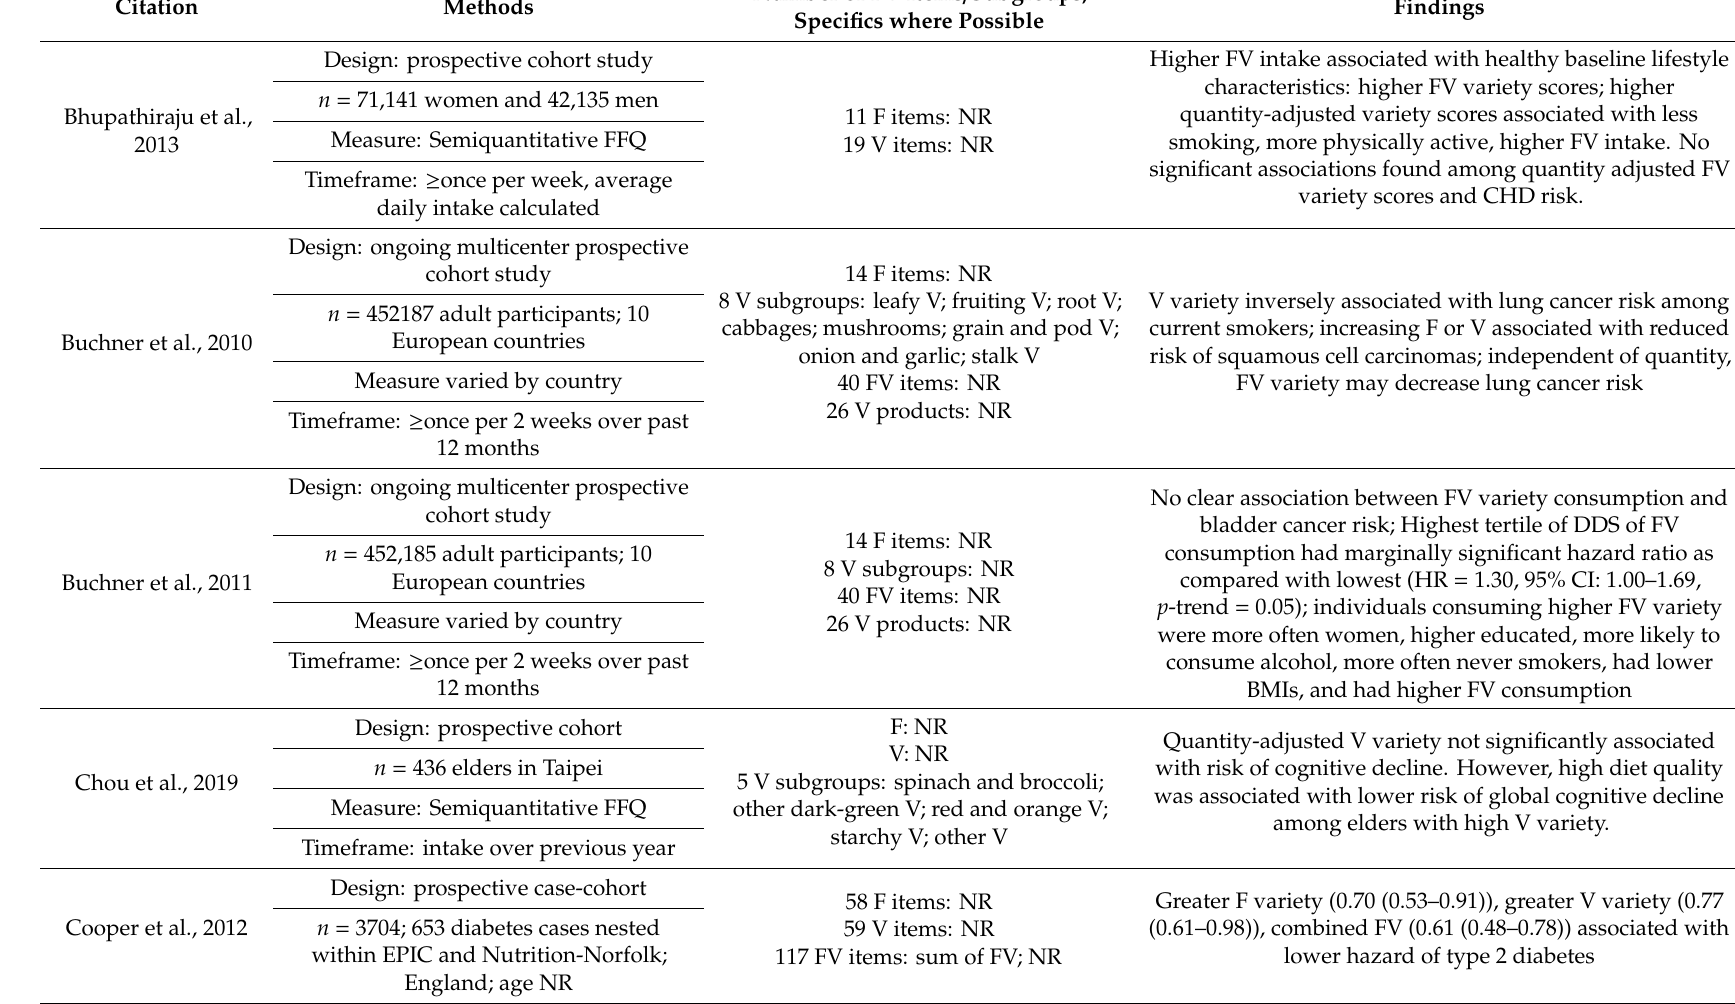
Table 4. Cohort studies, from the literature, assessing fruit and vegetable (FV)